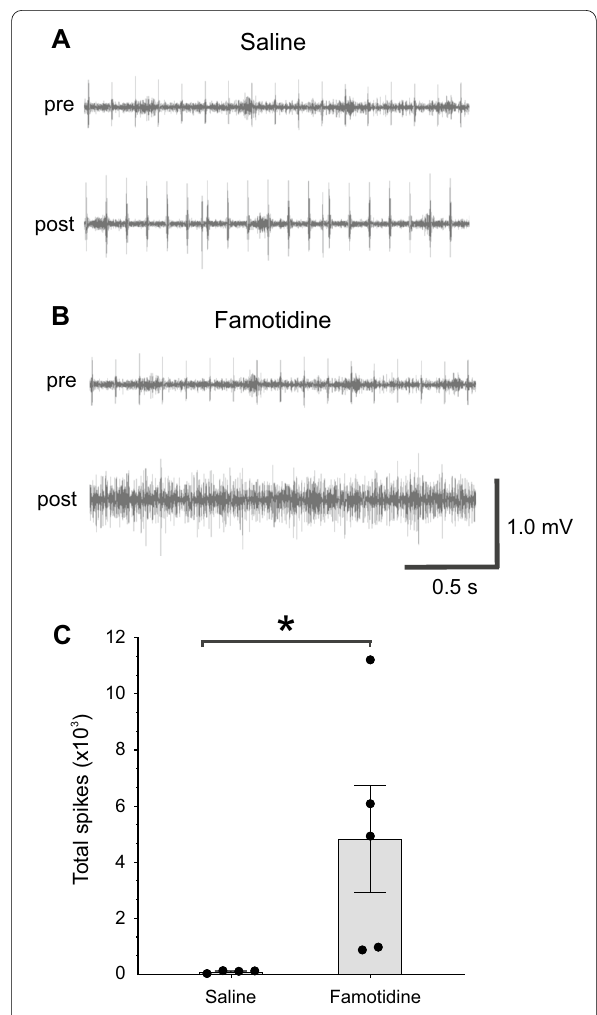
Fig. 4 Famotidine activates the vagus nerve. A , B Representative recordings of the vagus nerve signals in wild type mice pre- (baseline) and post- A saline or B famotidine administration ICV. Data is representative of 4 or 5 animals per group. Total spike count during recordings over the entire 4-min post-ICV administration of saline and famotidine. (n 4 for saline and 5 for famotidine). C *P = =